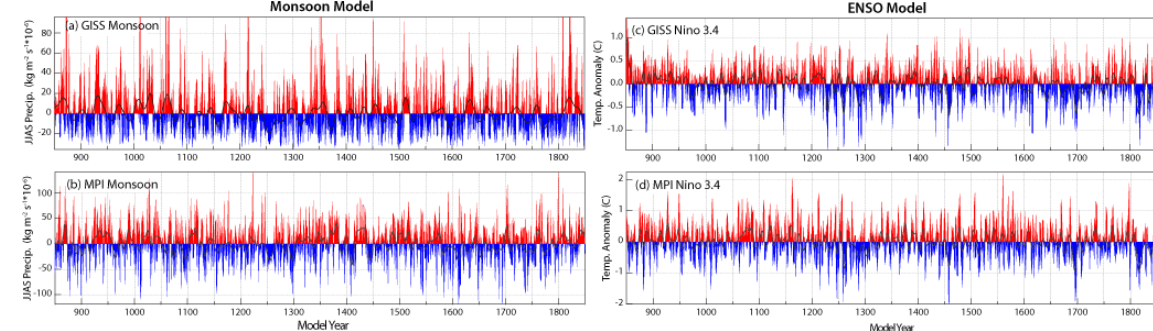
Fig. 5. Time series of the monsoon (a, b) and Niño3.4 (c, d) from the GISS (a, c) and MPI (b, d) models. The ISM precipitation is the sum of JJAS precipitation over India, and the ENSO time series is the annually averaged SSTs over the Niño 3.4 region. These 1000yr monthly resolved data were taken from the CMIP5 database (Taylor et al., 2012). No additional processing such as normalization was applied to the data.